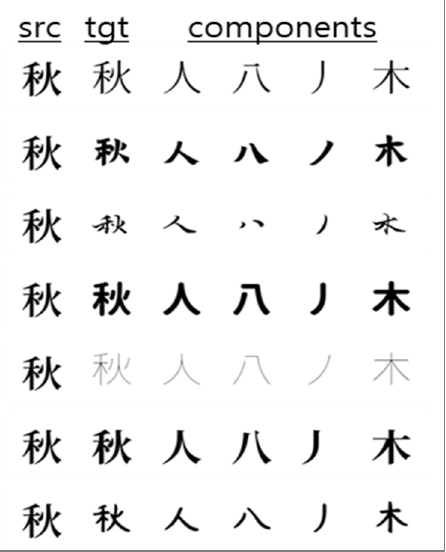
Figure 14. Examples of a character input dataset by font styles.